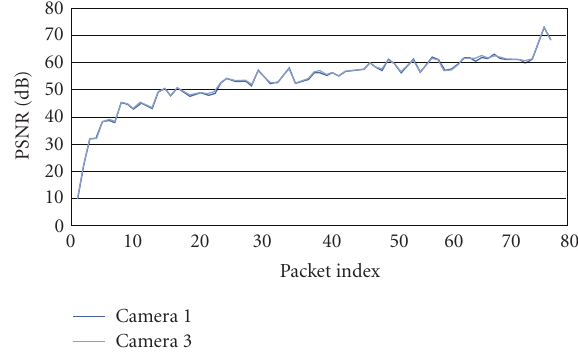
Figure 10: Breakdance : loss of a single packet of texture information (note how the two curves in the plot are almost superimposed).